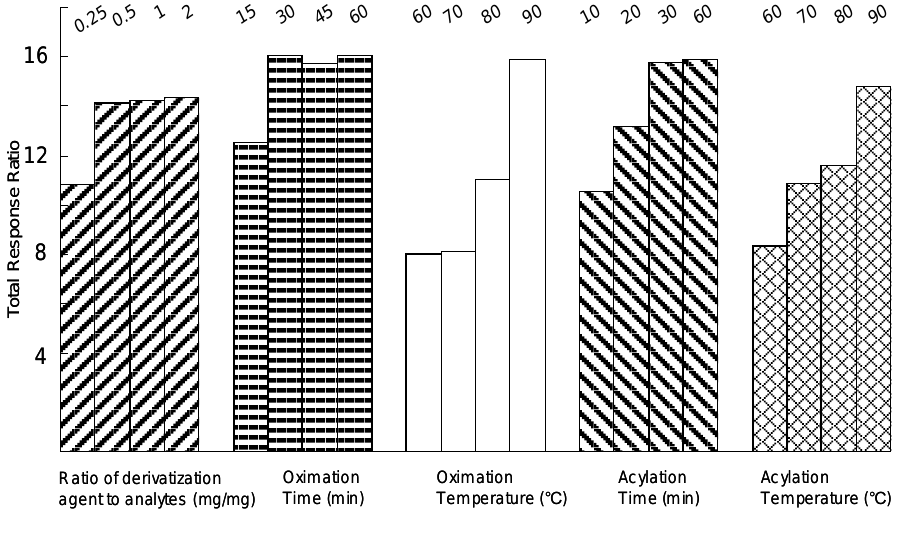
Figure 1. Optimization of derivatization of 10 investigated saccharides.